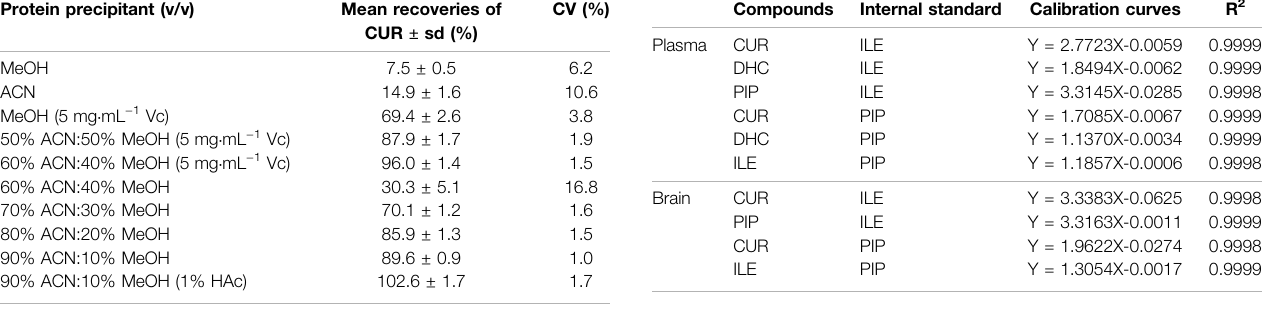
TABLE 1 | Ef fi ciency of protein precipitator (n (cid:1) 3). Protein precipitant (v/v)